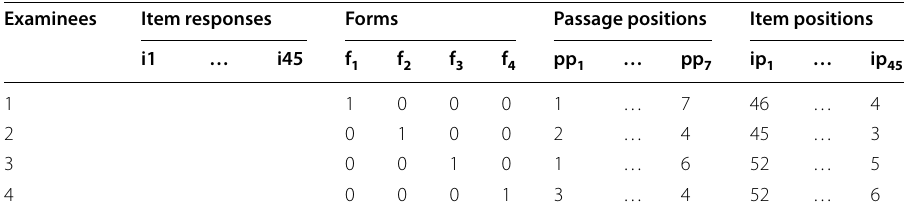
i1 to i45: dichotomous item responses; f1 to f4: dummy variables for the test forms; pp 1 to pp 7 : passage positions; ip 1 to ip 45 : item positions. Only one examinee from each test form was used to demonstrate the data layout